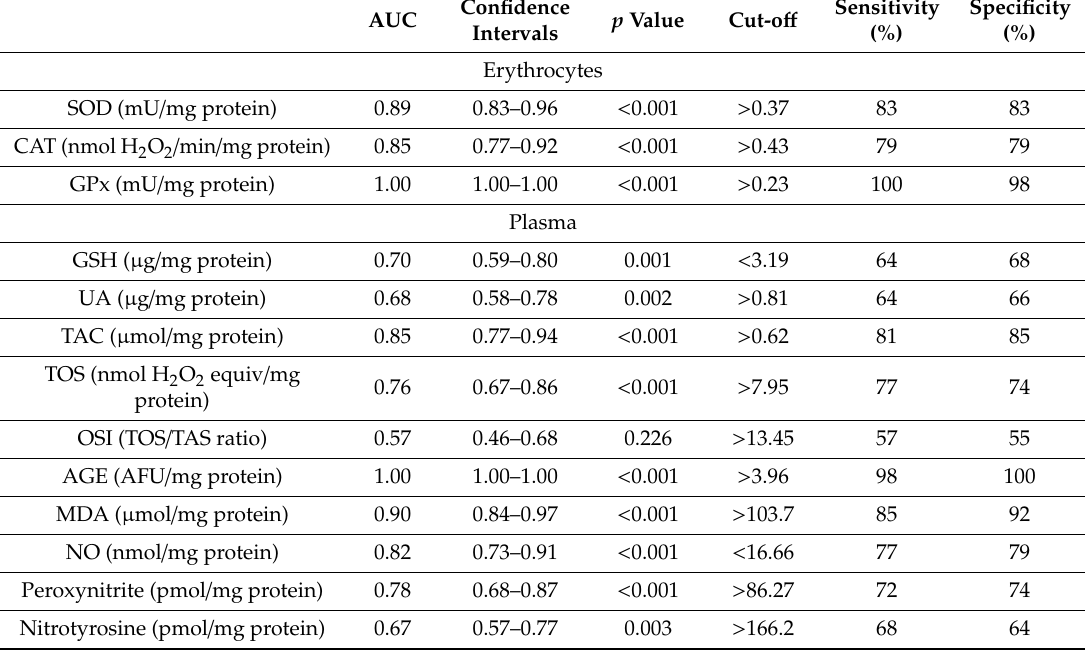
Table 7. Receiver operating characteristic (ROC) analysis of redox biomarkers in erythrocytes / plasma of children with hypertension and the control